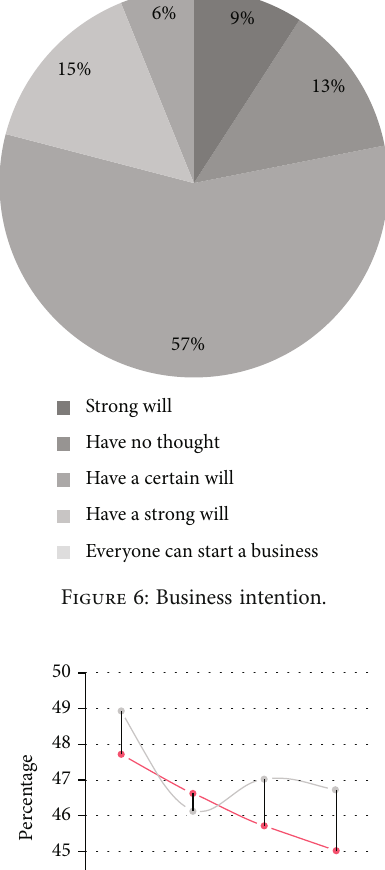
Figure 7: The proportion of self-employed entrepreneurs who insist on starting their own business half a year after